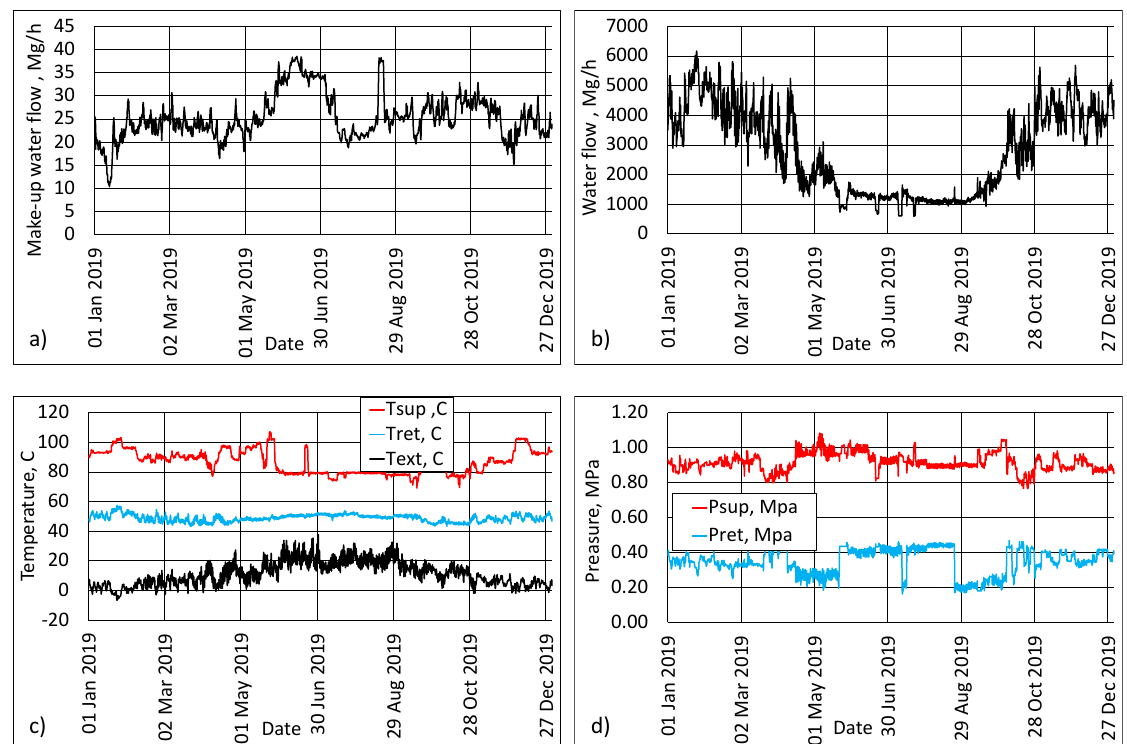
Figure 9. Measurements of DHS operation parameters in 2019: ( a ) water make-up; ( b ) water flow; ( c ) supply and return water temperature and outside air temperature; ( d ) water pressure in the supply and return network.